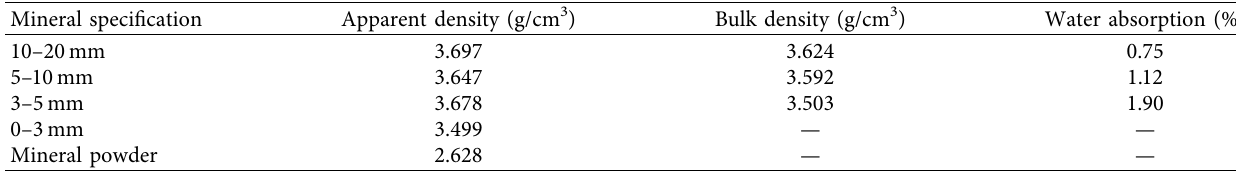
Table 2: Aggregate of SAM test results.